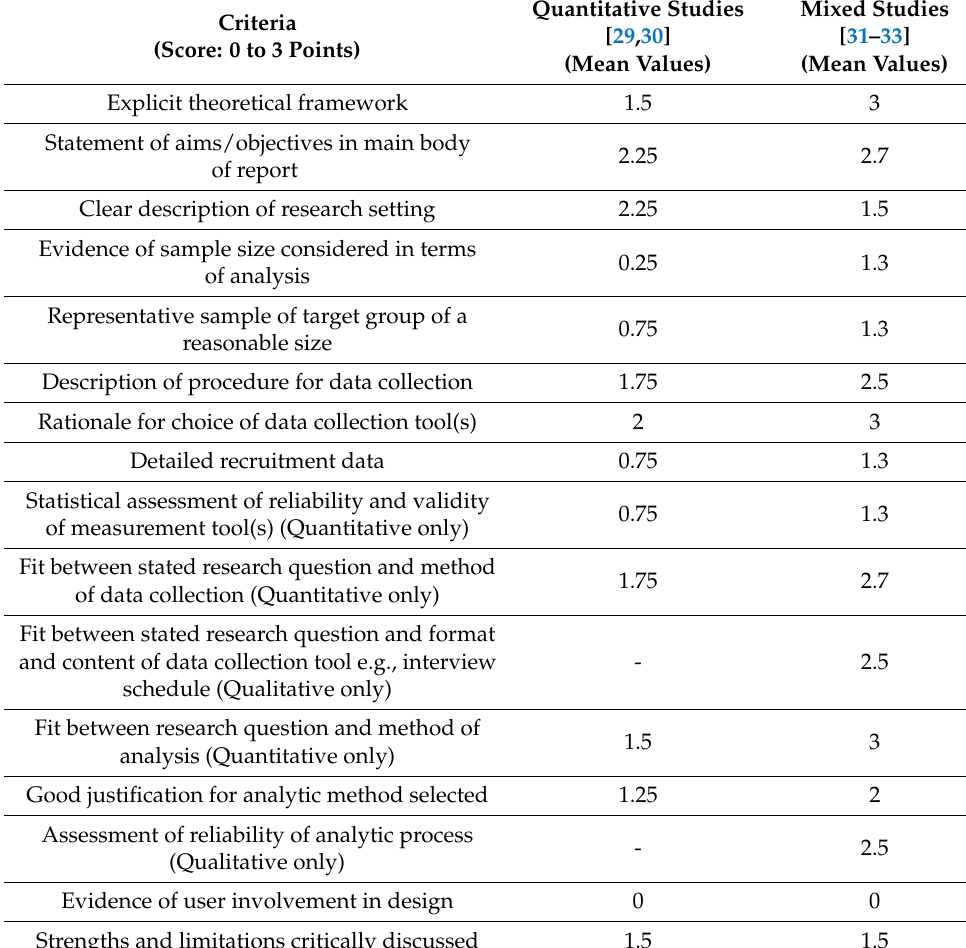
Table 2. Summary of methodological quality scores according to the study